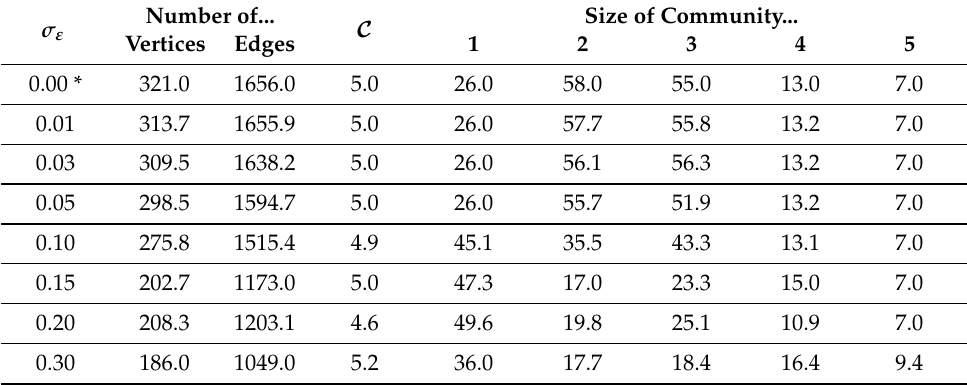
Table 2. Results of the measurement error analysis. Number σ ε